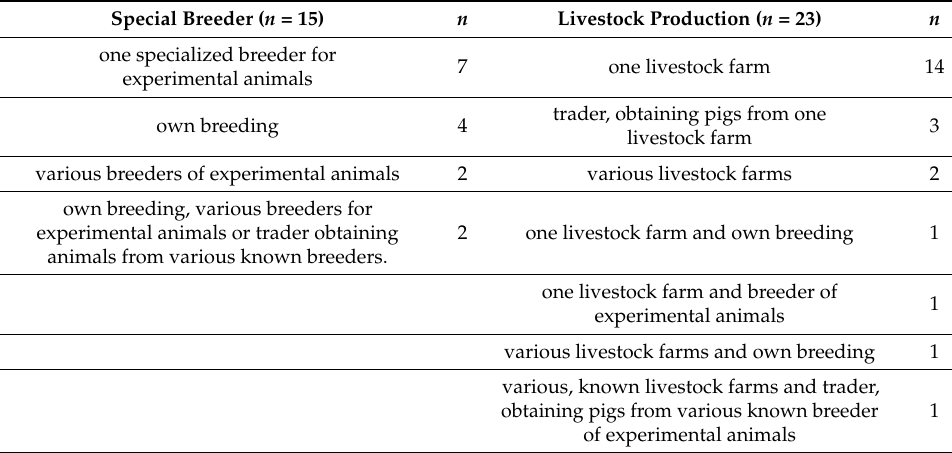
Table 3. Origin of pigs used for experimental